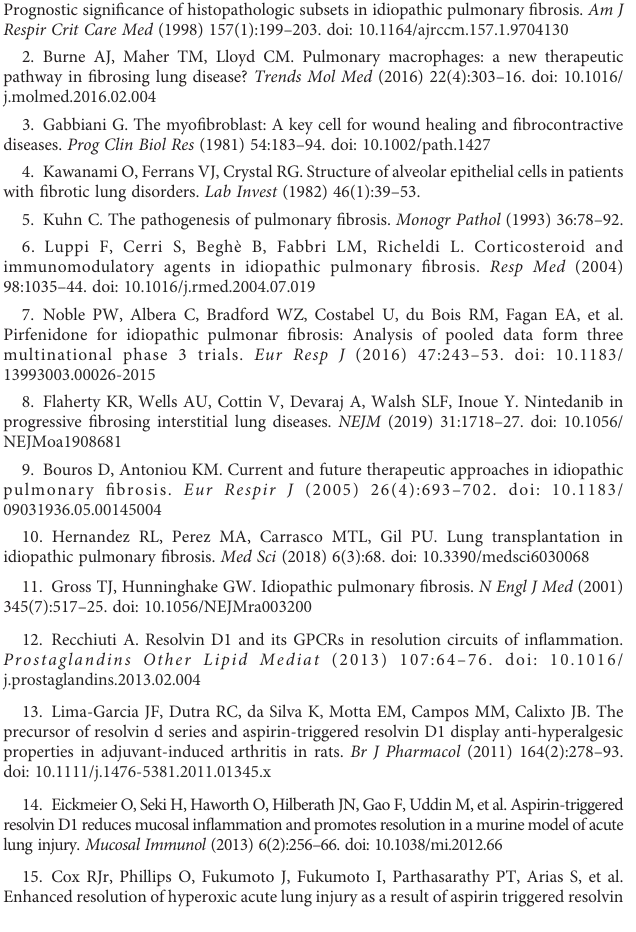
SUPPLEMENTARY FIGURE 1 Early fi brosis markers 7 days after bleomycin i.t. challenge. Lungs were harvested on the 7 th day after SAL or BLM (0.06 U/mouse in a fi nal volume of 30 m L of SAL) challenges, as described in the Materials and Methods section. (A) Representative lung sections from SAL (left) and BLM (right) groups stained for hematoxylin and eosin. (B) Picrosirius red staining under bright fi eld (superior images) and polarized light (lower images) images obtained from the same groups. Pictures are representative of each group, constituted of n=4. Bar scale = 50 m